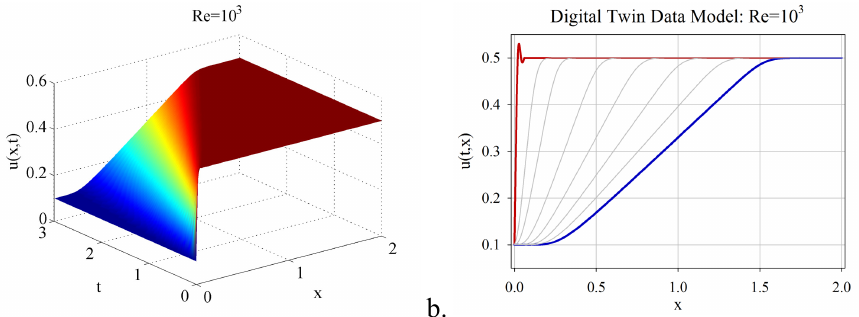
Figure 11. Solution of the digital twin data model in the case of experiment Re = 10 3 : ( a ) 3D view; ( b ) Projection view of the shock wave.